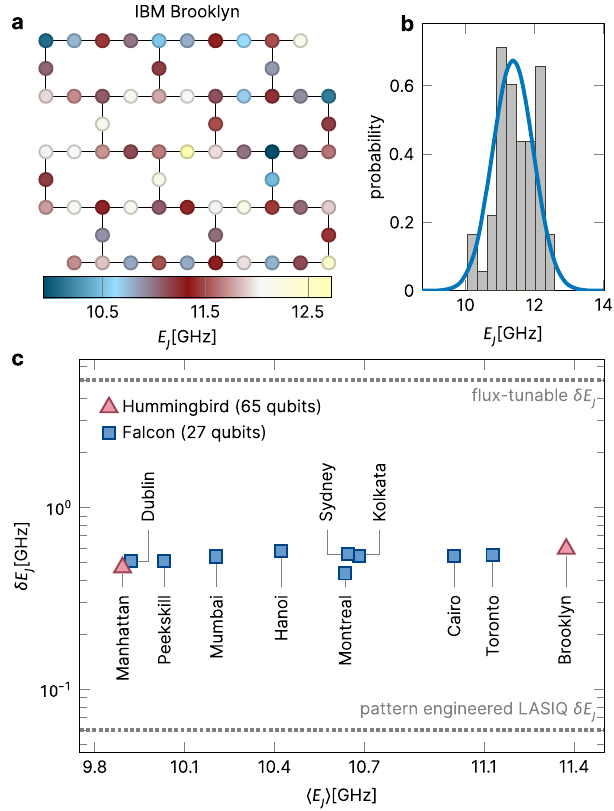
Fig. 1 Experimental parameters of recent IBM transmon arrays. a Layout of the 65-qubit transmon array “ Brooklyn ” , currently available in IBM ’ s quantum cloud (https://www.ibm.com/quantum-computing/systems/), in a heavy-hexagon geometry. The coloring of the qubits indicates the variation of Josephson energies E J which is largely uncorrelated in space. b Spread of the E J plotted for the “ Brooklyn ” chip, consistent with a Gaussian distribution (solid line). Similar levels of disorder and distributions are found in all transmon devices available in IBM ’ s quantum cloud. c Variance of the measured Josephson energies, δ E J , for nine realizations of the 27-qubit “ Falcon ” design, and two realizations of the 65-qubit “ Hummingbird ” design. While the mean varies unsystematically from device to device, the variance remains very consistent, setting the parameter favored in our “ scheme A ” study below. “ Scheme B ” cases in other labs have a much larger spread as indicated by the “ fl ux tunable ” level in the fi gure. Recent proposals of using high precision laser-annealing 12 as a pattern engineering approach 13 , discussed towards the end of the manuscript, aim for a signi fi cant reduction of the E J variance; such pattern- tuned transmon arrays have so far not appeared in any cloud